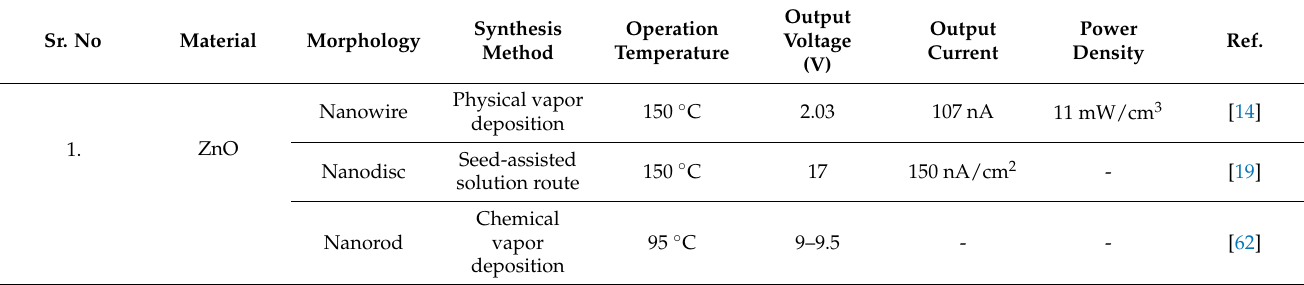
Table 1. Some examples of piezoelectric materials with their different